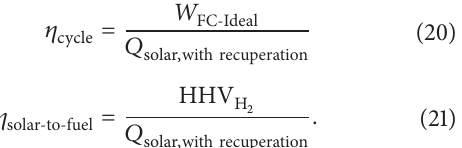
and 𝜂 of Tb-WS cycle solar-to-fuel